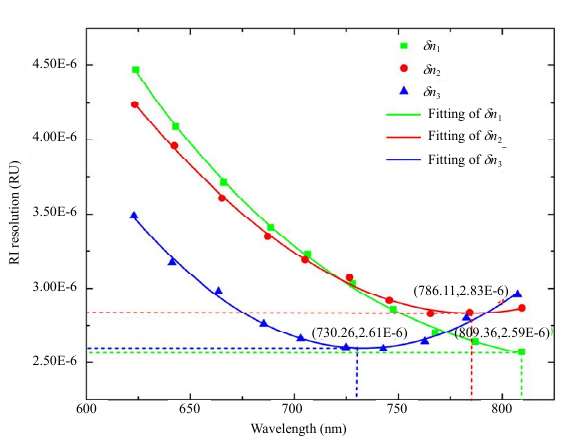
Fig. 9 Fitted curves for the RI resolution of the resonant wavelength.